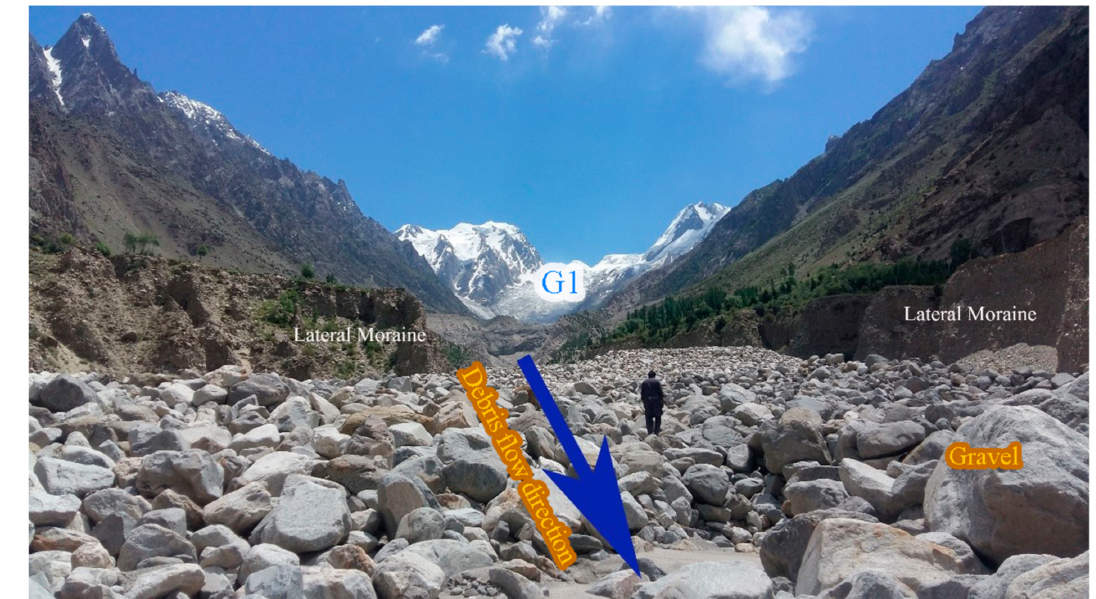
Figure 2. Photograph of the debris flow taken on 21 July 2019 (taken by Anjum, Muhammad Naveed).